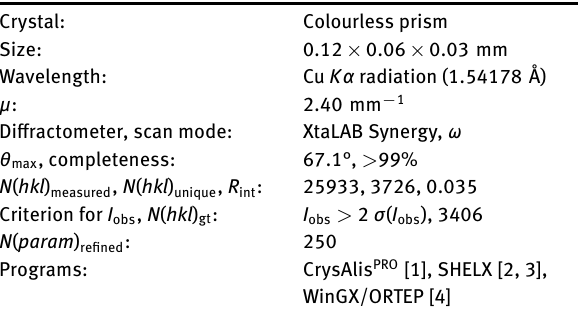
The molecular structures of the ions are shown in the figure. Table 1 contains crystallographic data and Table 2 contains the list of the atoms including atomic coordinates and dis- placement parameters. Table 1: Data collection and handling.